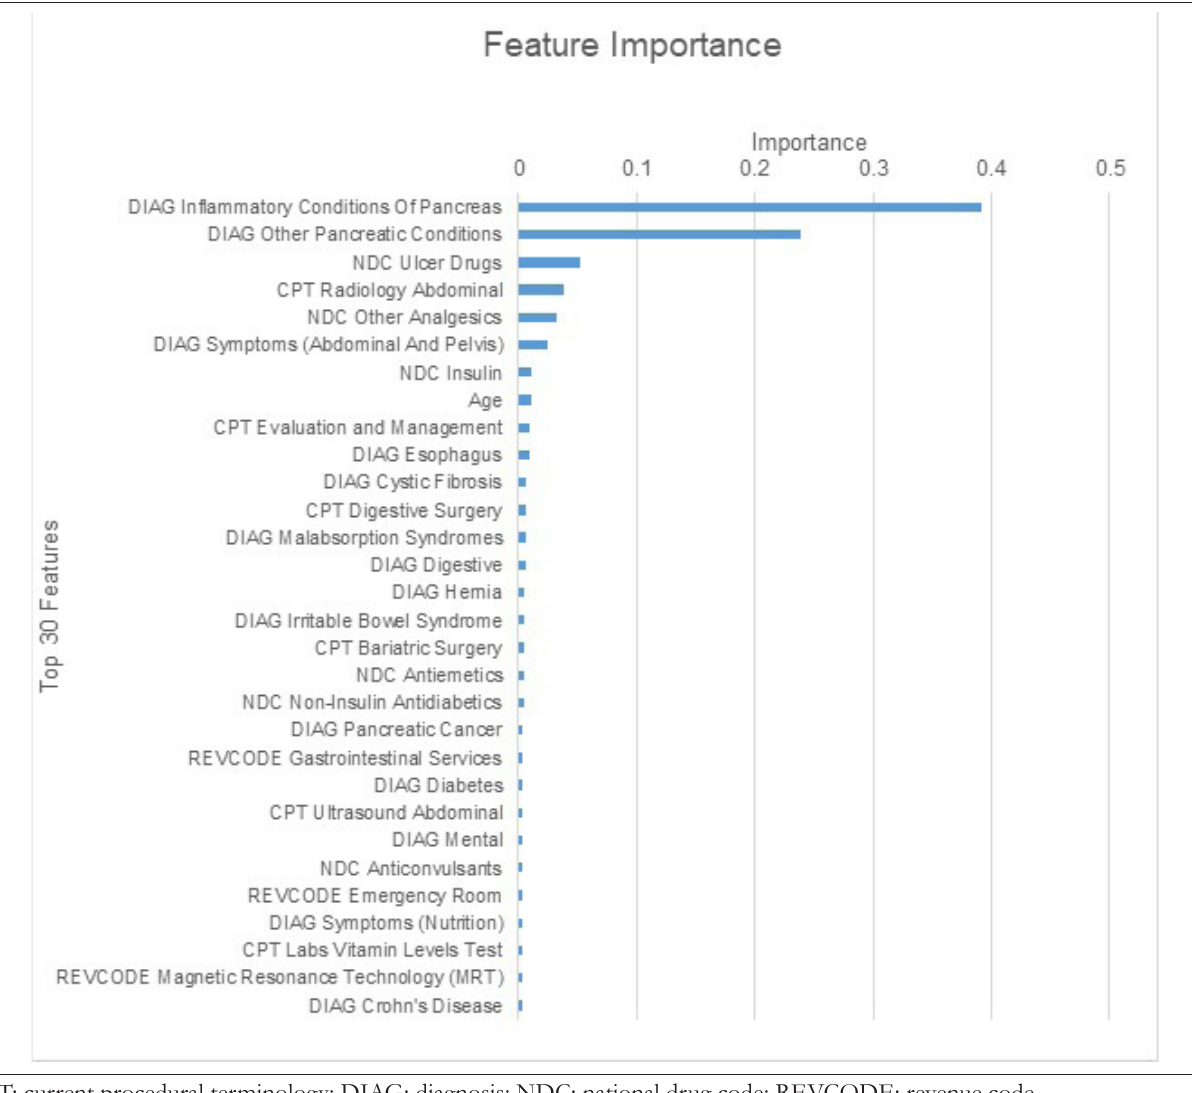
Table 7. Summary of Model 3 Feature Importance as Measured by Each Feature’s Contribution